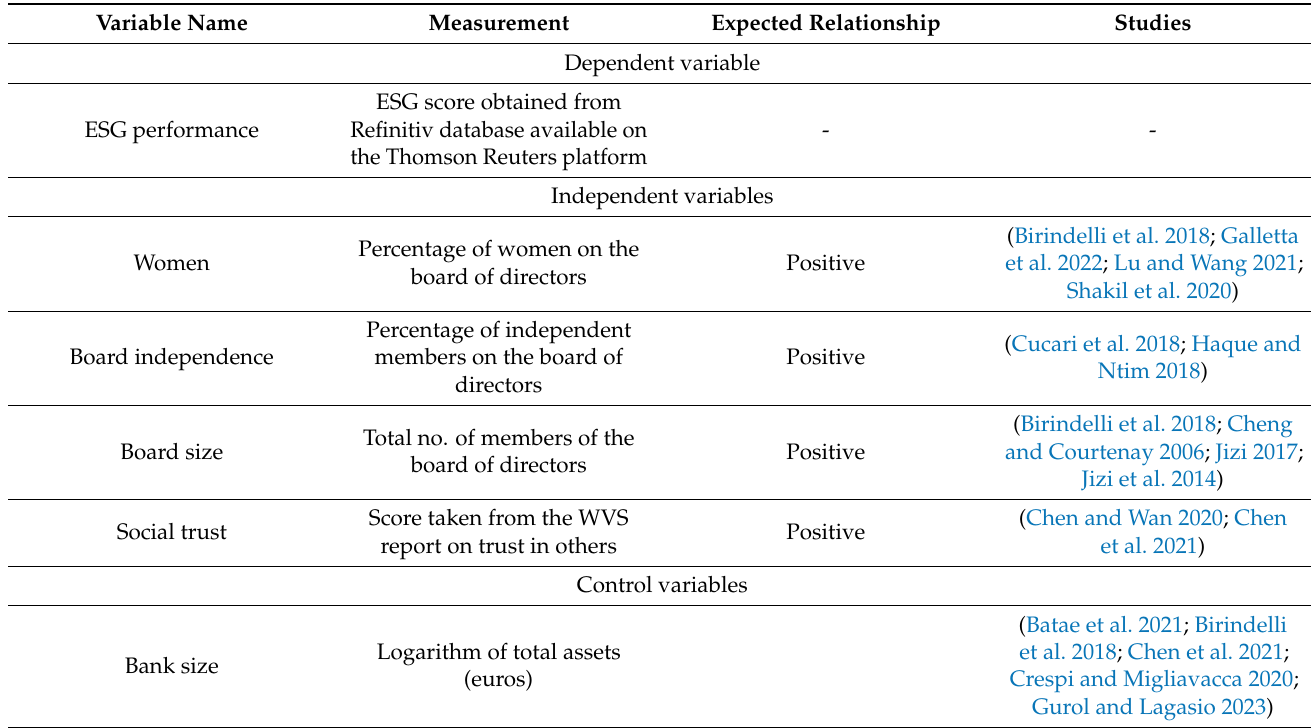
Table 1. Description of